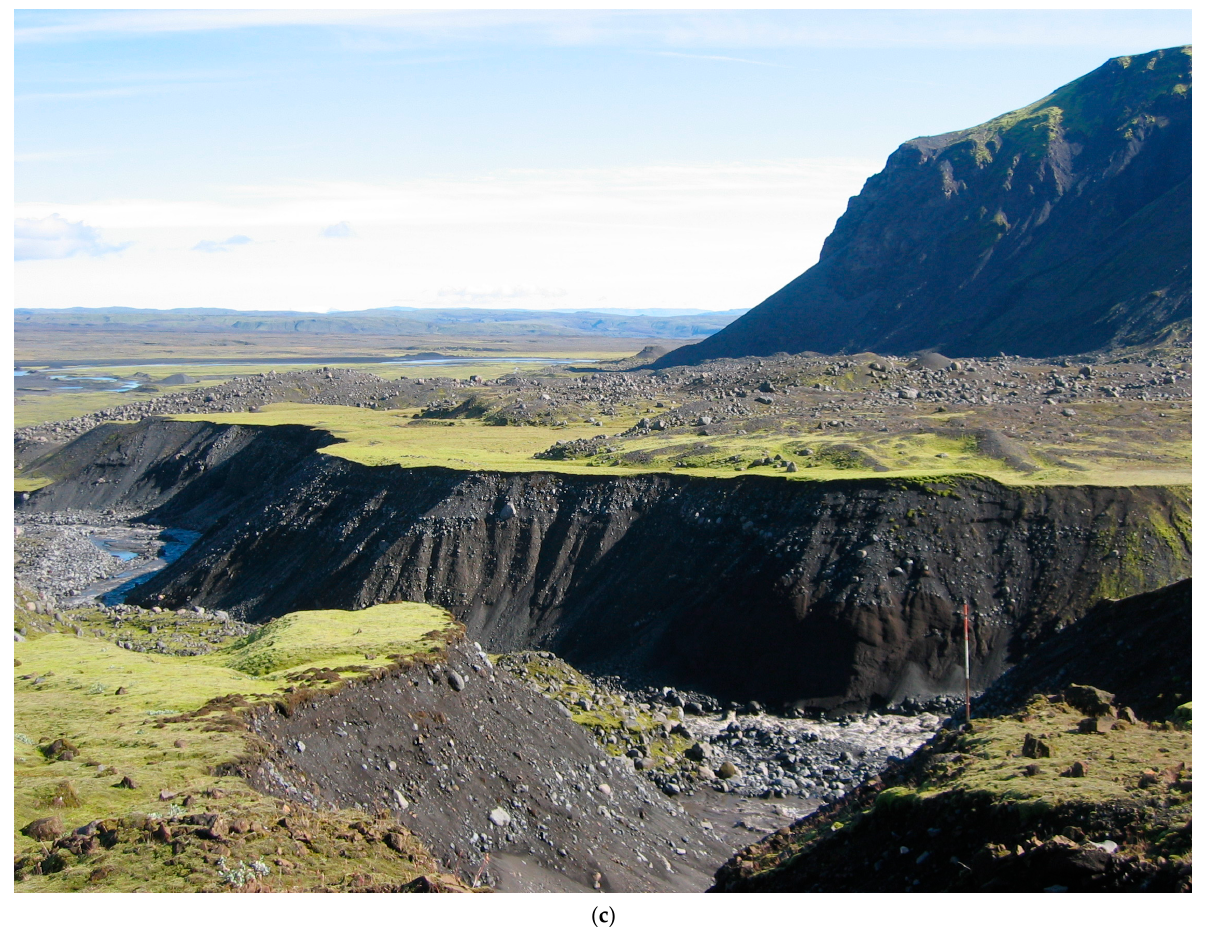
Figure 14. Glacifluvial landforms around the margins of Sandfellsjökull: ( a ) Aerial photograph extract (NERC ARSF 2007) of extensively pitted outwash and kame and kettle topography on the south foreland, and containing chains of elongate ponds; ( b ) Aerial photograph extract (NERC ARSF 2007) showing englacial eskers emerging on the downwasting glacier surface and associated ice-contact fans; and, ( c ) Glacially overridden, pre-LIA outwash on the south foreland overlain by a gravelly till veneer and push moraines.